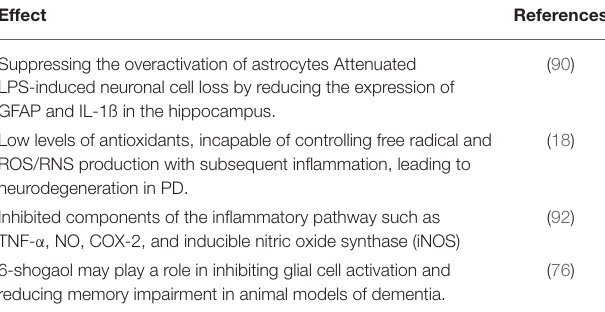
TABLE 3 | Parkinson’s disease and